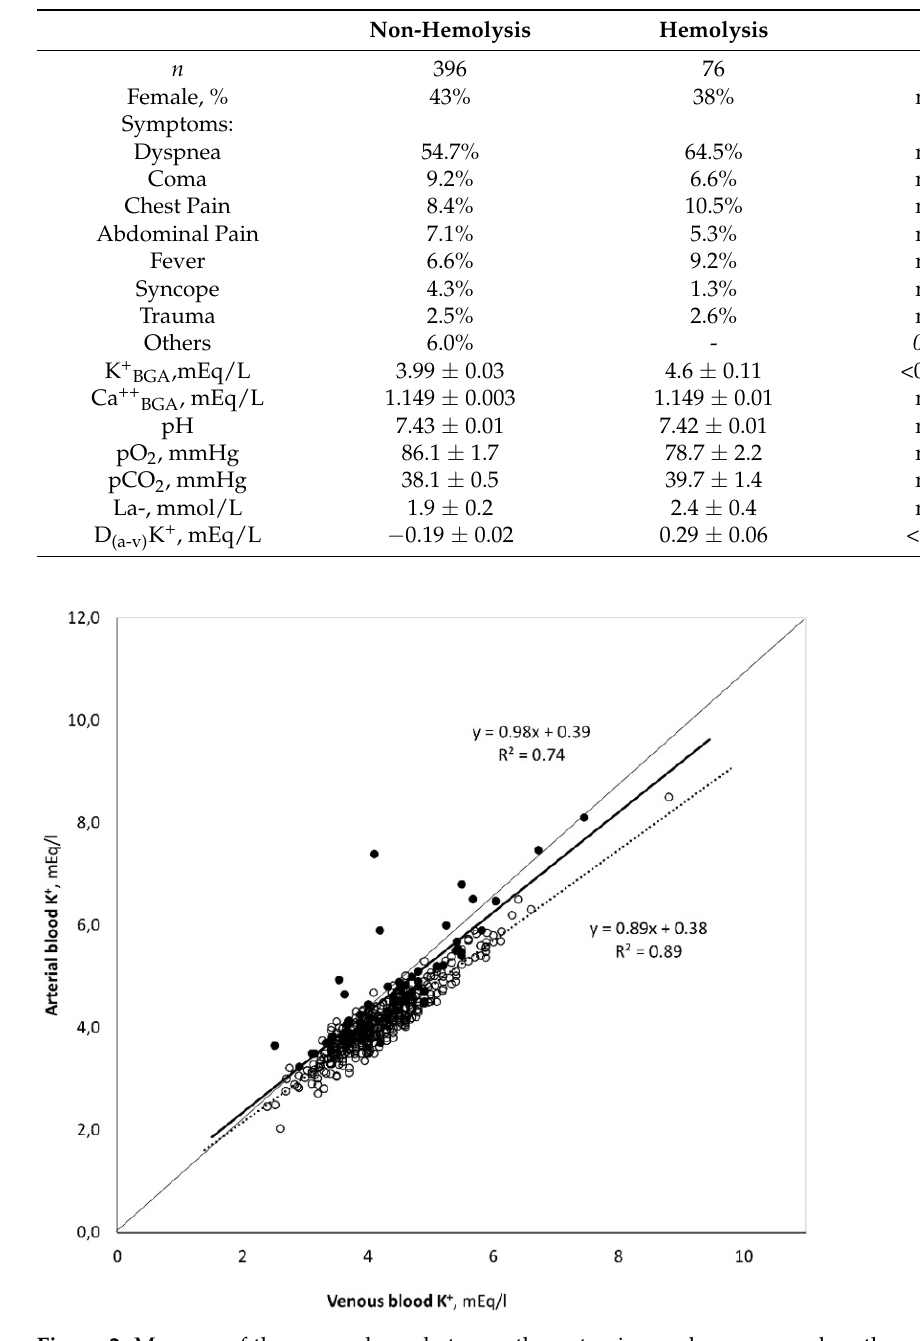
Figure 2. Measure of the concordance between the potassium value measured on the venous and arterial sample. ( ○ = non-hemolyzed; ● hemolyzed).